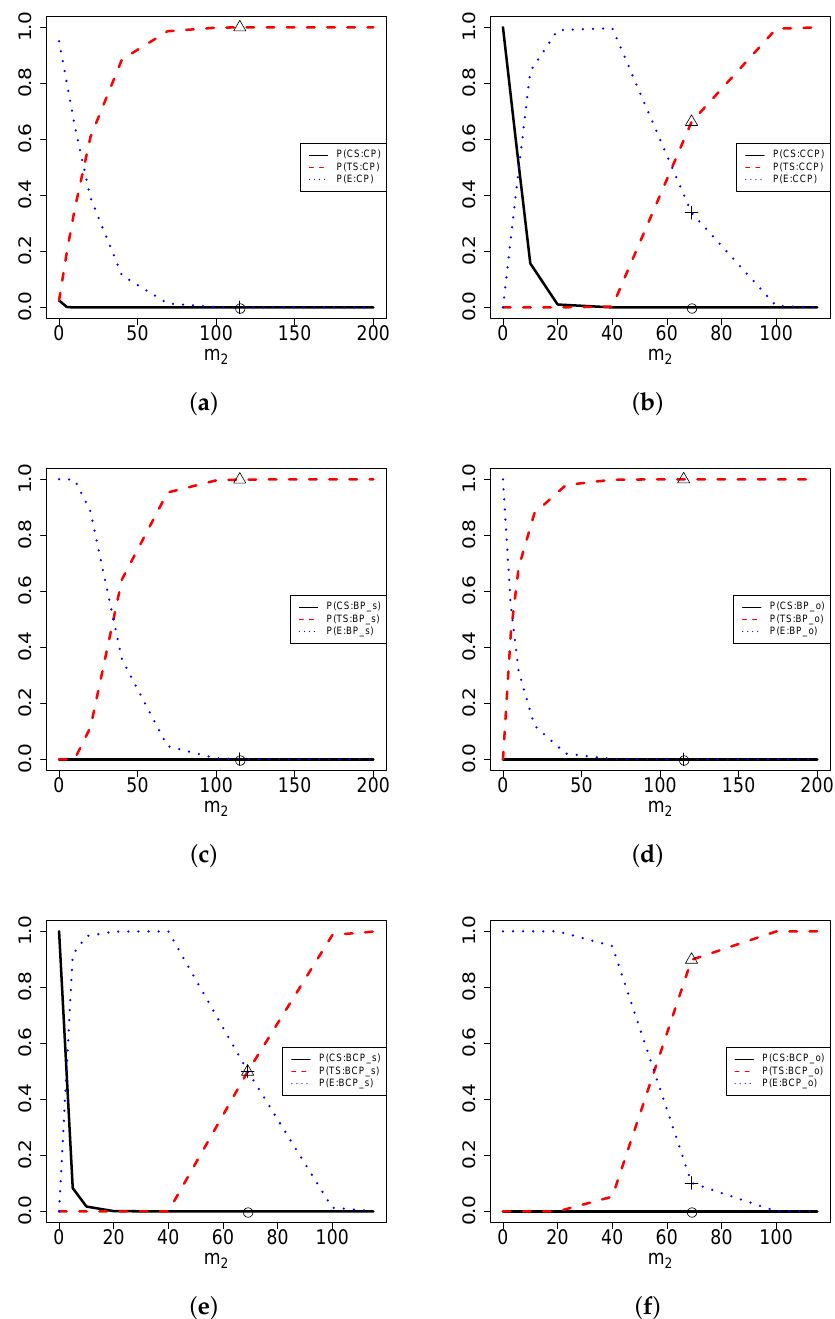
Figure 4. The probabilities of CS, TS, and E for CP, CCP, BP, and BCP as functions of m 2 when δ = − 1, which favors treatment. ( a ) CP; ( b ) CCP; ( c ) BPs; ( d ) BPo; ( e ) BCPs; ( f ) BCPo. (1) Compared to Figure 3, since δ = 1 favors control and δ = − 1 favors treatment, the probabilities of CS in Figure 4 are smaller than those in Figure 3, while the proba- bilities of TS in Figure 4 are larger than those in Figure 3. (2) The central two plots are for BP, with the left plot being a sceptical prior and the right plot being an optimistic prior. The two plots display similar patterns of increasing and decreasing characteristics. The optimistic prior favors treatment, and thus, P ( TS:BP_o ) is larger than P ( TS:BP_s ) . The sceptical prior favors control; however, the two